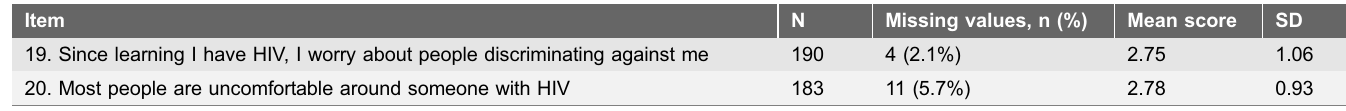
Table 3. Cont. Item